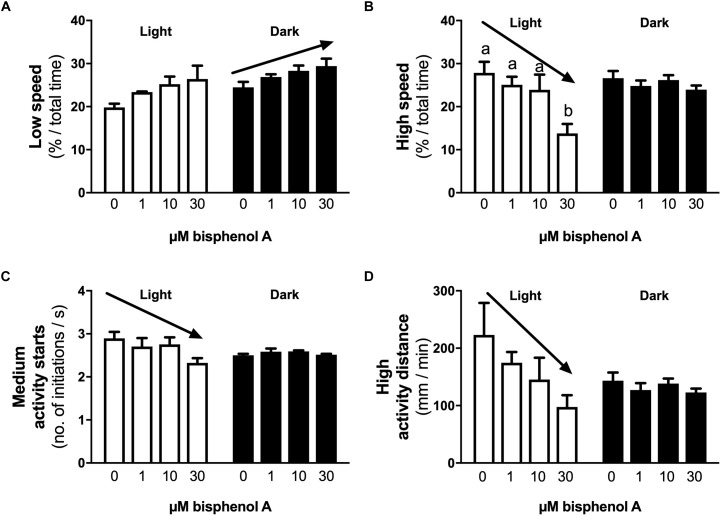
The effects of early developmental exposure to BPA on zebrafish embryo locomotor activity in large wells at 5 dpf (Variant 4, see methods). The amount of time (% of total) that 5 dpf zebrafish larvae moved at low (A) or high (B) speeds, the number of times zebrafish larvae initiate medium (C) levels of activity, and the distance covered when moving at high speeds (D), under either light (open bars) or dark (black bars) after aqueous exposure to graded levels of BPA (0–30 μM) between 2 and 26 hpf. Solid arrows represent linear responses to increasing BPA exposure concentrations (p < 0.05, graph A, y = 26.0 + 0.13x, R2 = 0.36; graph B, y = 27.1 – 0.43x, R2 = 0.65; graph C, y = 2.8 – 0.016x, R2 = 0.40; graph D, y = 196 – 3.5x, R2 = 0.37). Letters indicates statistical differences in mean values between treatments with ANOVA (one-way ANOVA, Tukey post hoc test, p < 0.05). Data are the mean ± SEM, n = 3, where each replicate is the average of 3 larvae.